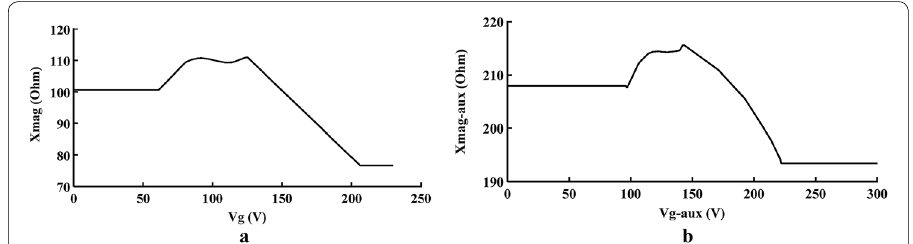
Fig. 5 The magnetization characteristic for a main winding and b auxiliary